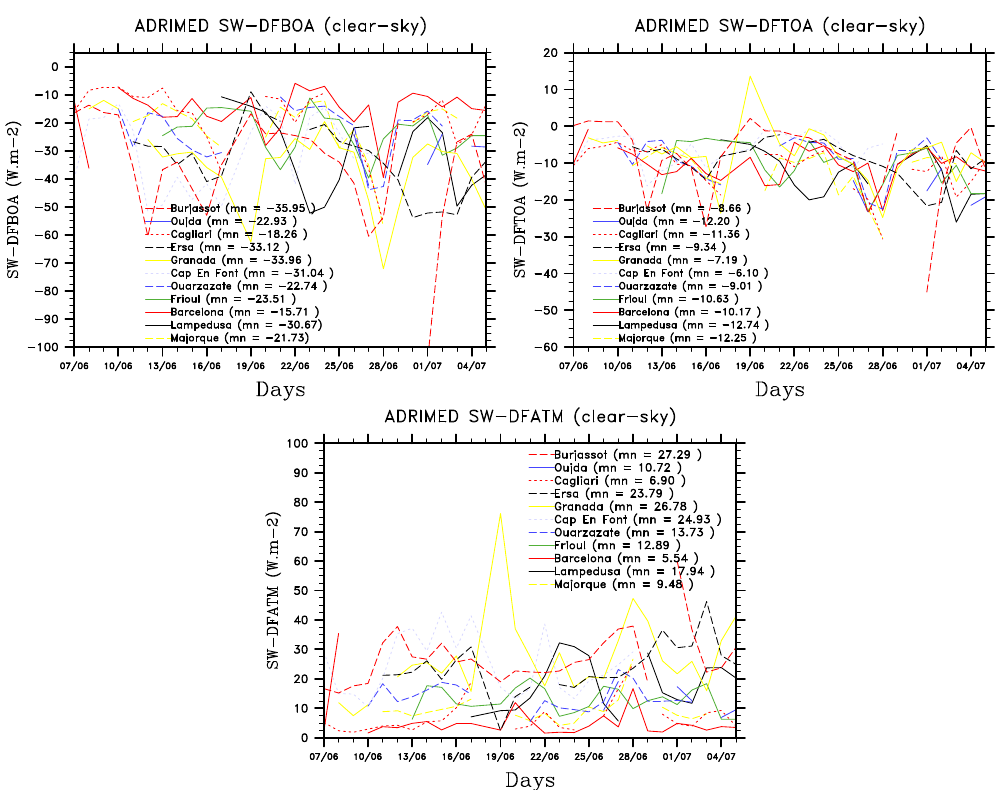
Figure 26. One-dimensional (clear-sky) instantaneous (shortwave only) DRF calculations (in Wm − 2 ) based on the AERONET/PHOTONS data set for the different stations listed in Table 2 (BOA, TOA and ATM refer to the bottom of the atmosphere, top of atmosphere and atmospheric forcings).